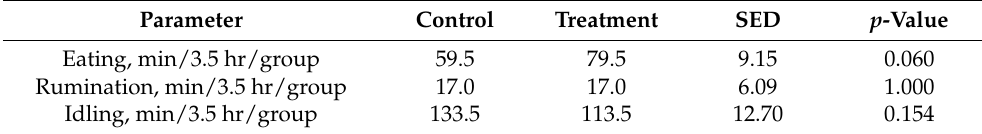
Table 5. Effects of feeding a diet containing 20% grape marc on behaviour of merino sheep. Parameter Control Treatment Eating, min/3.5 hr/group Rumination, min/3.5